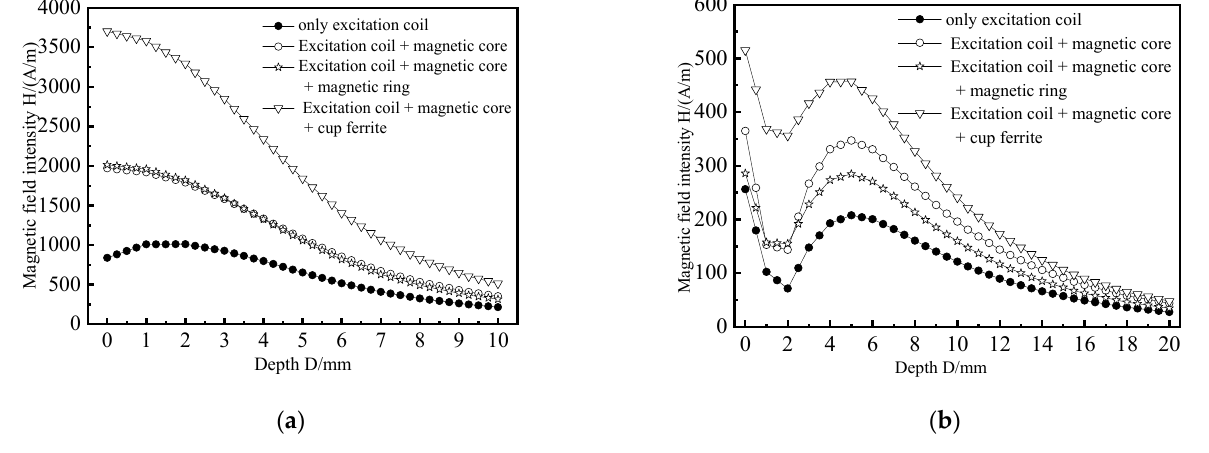
Figure 8. The influence of the magnetic circuit structure on the indirect coupling magnetic field. ( a ) Directly below the excitation coil; ( b ) Web position.